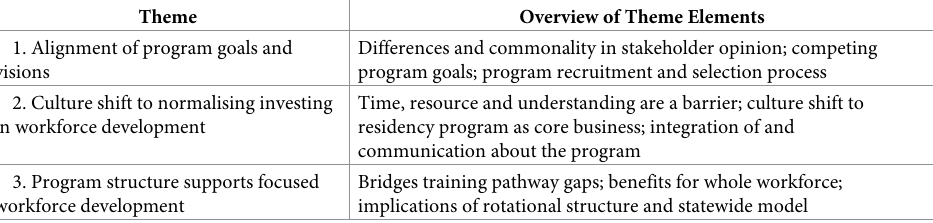
Table 2 outlines the three themes identified that focus on stakeholders’ expectations and early perceptions of the role, structure and vision of the South Australian statewide foundation Table 2. Overview of